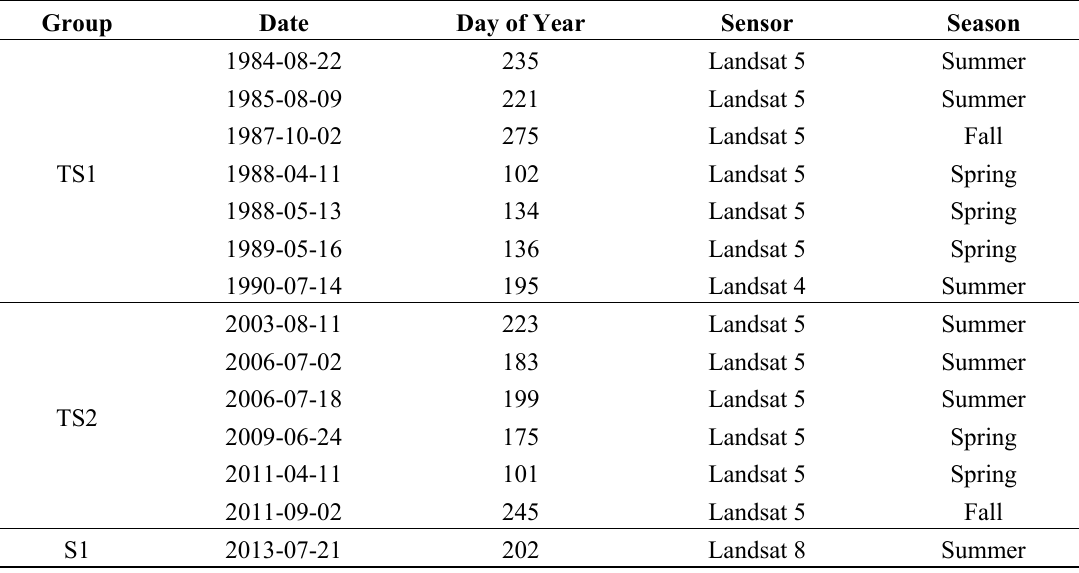
Table 2. All Landsat images used for the land cover classification including two groups (TS1 and TS2) of time series of Landsat 4/5 images from 1984 to 2011 and the single-date Landsat 8 image (S1) in July